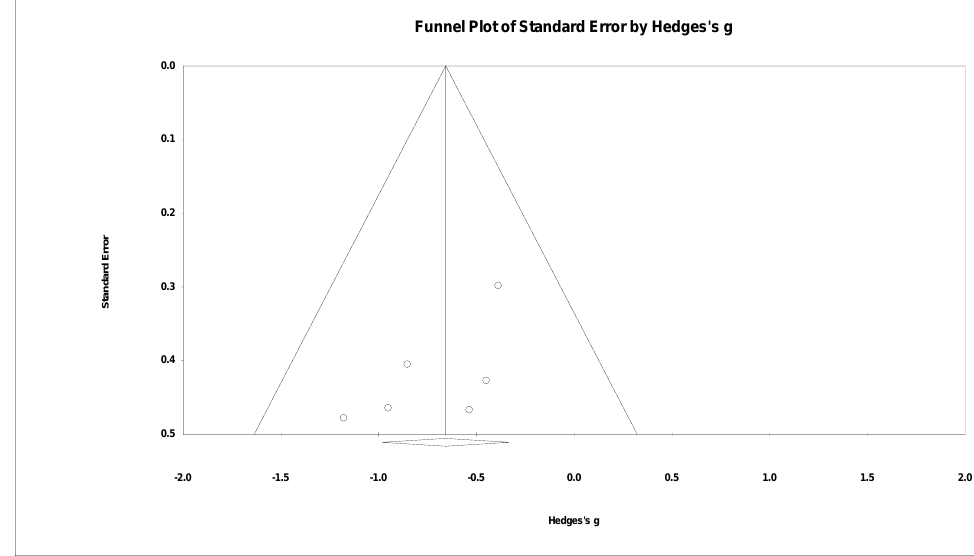
Figure 6. Funnel plot for meta-analysis of the effect of neuro-feedback training on PTSD diagnosis.